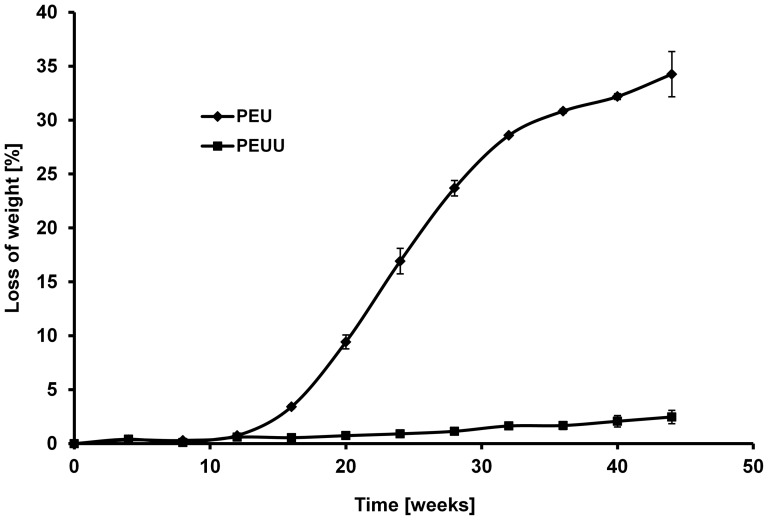
Degradation of compact samples of PEUU and PEU within 44 weeks in Sörensen phosphate buffer at 37°C.